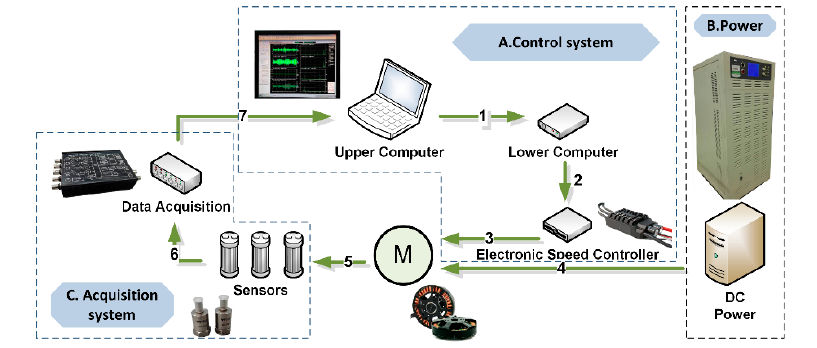
Table 2. Connections between equipment.